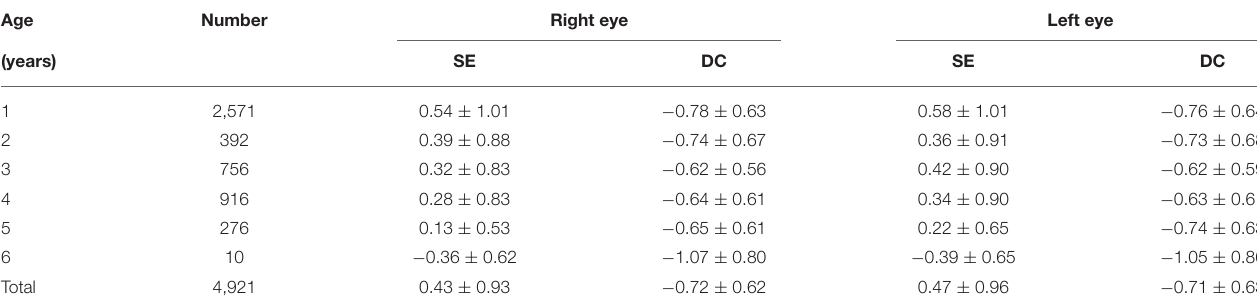
SE, spherical equivalent; DC, cylinder